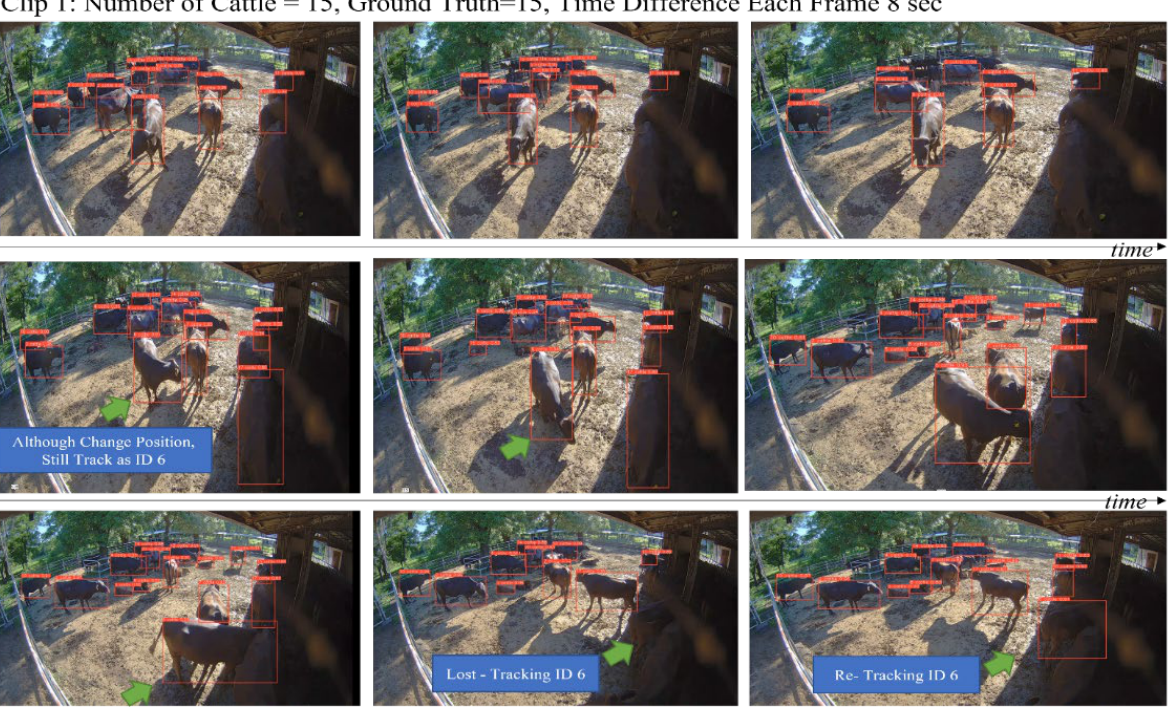
Figure 10. A comparison of detection results between the one- and two- stage detectors .